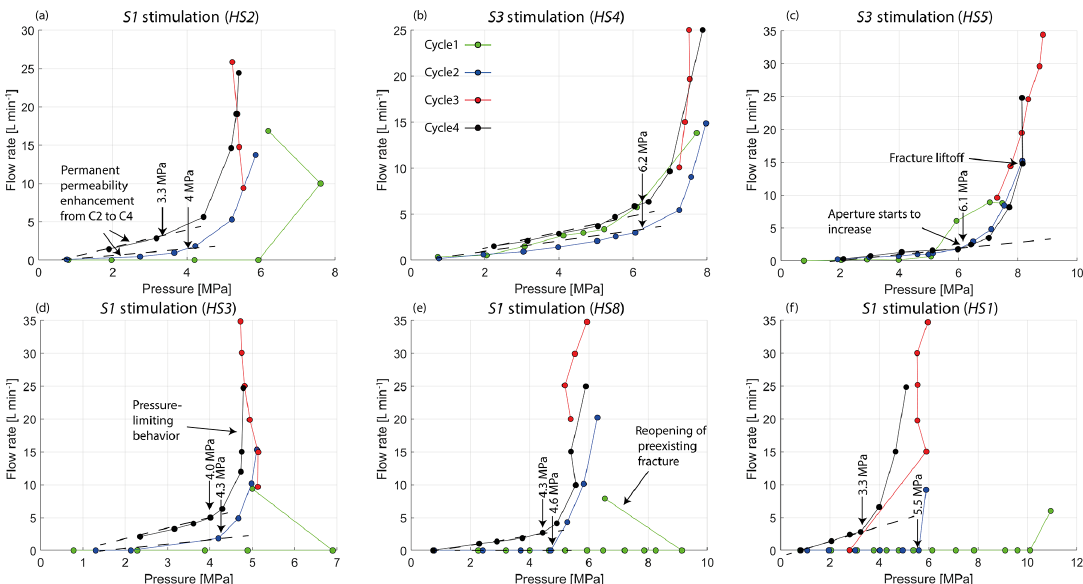
Figure A3. P – Q diagrams for all conducted HS